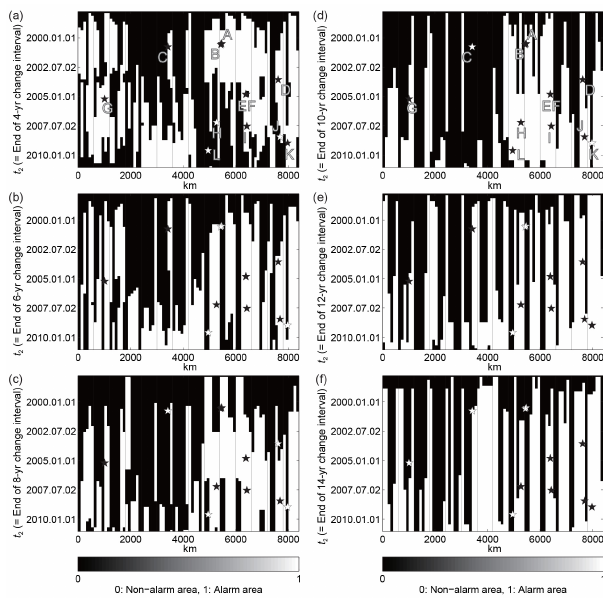
Fig. 7. As in Fig. 6, but for a cutoff magnitude of 4.0.